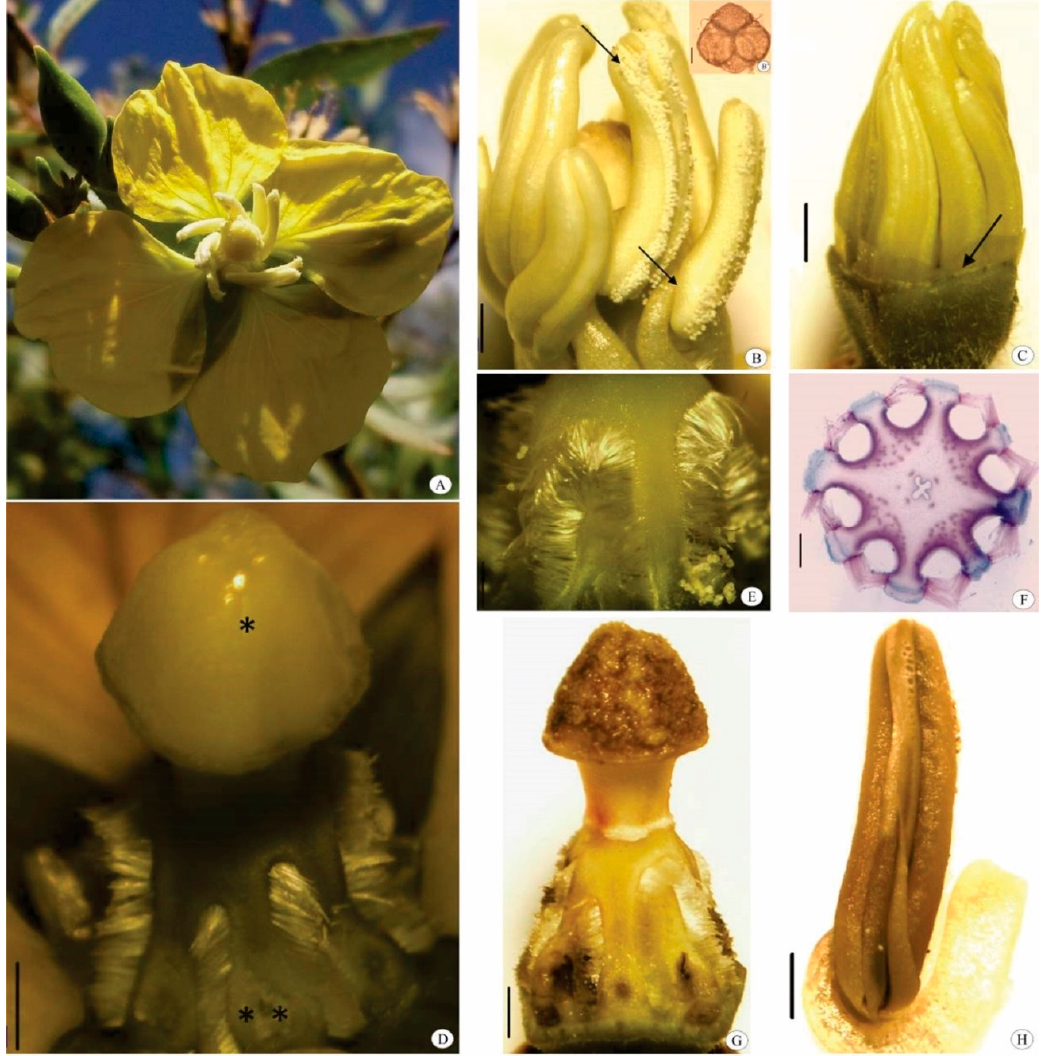
Figure 3. Some aspects of floral biology of Ludwigia nervosa . ( A ) Detail of floral morphology; ( B ) Dorsifixed anther (arrow) with longitudinal dehiscence (arrow) initiating pollen release, ( B’ ) Pollen tetrad with viscin threads; ( C ) Corolla development (arrow); ( D ) Wet-looking stigma (*); Nectary (**); ( E ) Detail of nectary with trichomes; ( F ) Cross section of nectary; ( G ) Senescent gynoecium; ( H ) Senescent anther. Bar = 0.10 cm ( B – D , G , H ), 10 μ m ( B’ ), 0.05 cm ( E ), and 500 μ m ( F ).